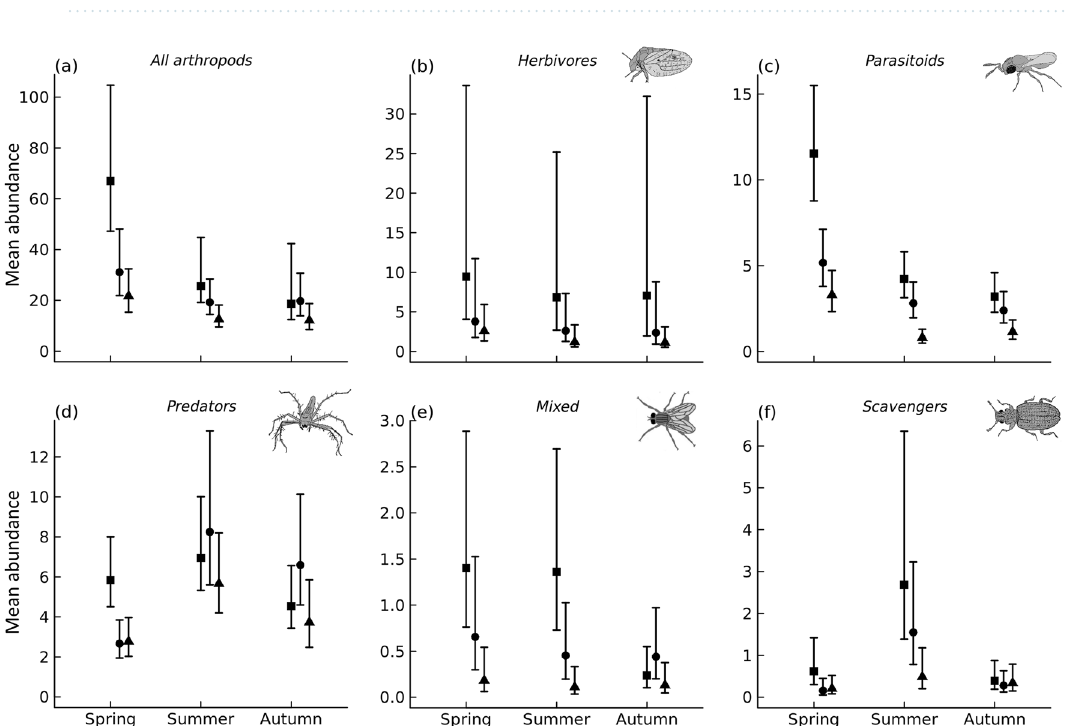
Figure 3. Seasonal variation in total arthropod abundance and abundance per trophic group predicted from Hierarchical Modelling of Species Communities (posterior mean and 84% credible intervals), across orchard intensification levels: traditional (squares), intensive (circles) and superintensive (triangles). Arthropod drawings by Juan Pablo